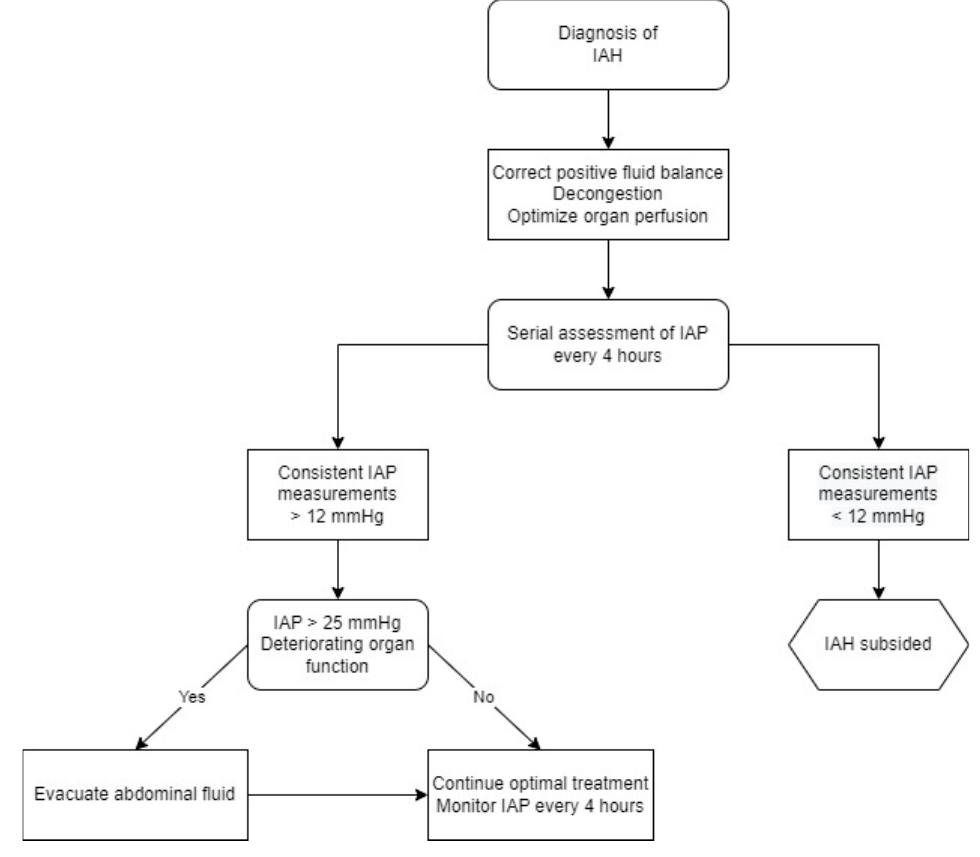
Figure 4. Management algorithm for intra ‐ abdominal hypertension. IAP—intra ‐ abdominal pressure, IAH—intra ‐ abdominal hypertension.